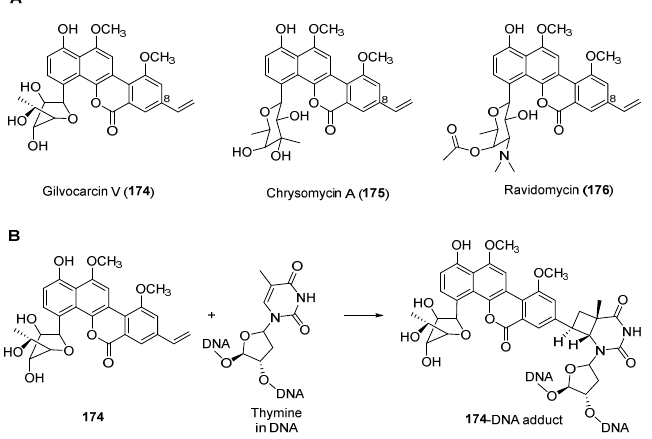
Figure 23. ( A ) Chemical structure of gilvocarcin V, chrysomycin A, and ravidomycin. ( B ) Mode of action of vinyl-containing gilvocarcin-type natural action of vinyl-containing gilvocarcin-type natural products.